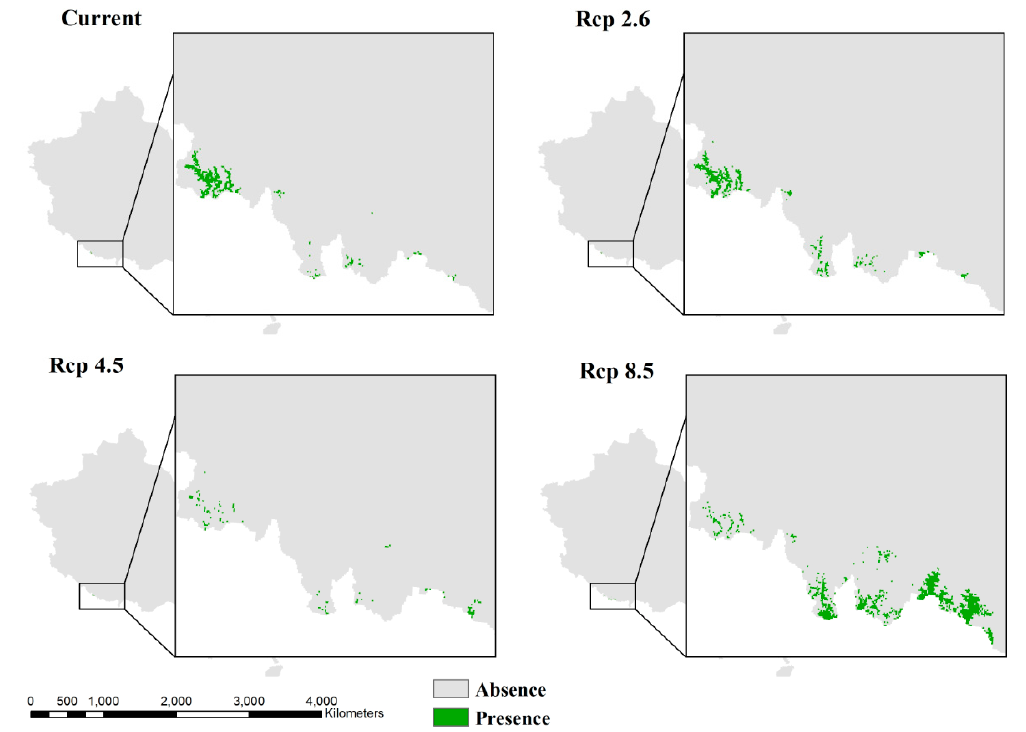
6 of 16 Figure 2. Binary distribution maps for T. cuspidata under current and future (RCP 2.6, RCP 4.5, and RCP 8.5 in 2070) environmental conditions, simulated by SDMs with the constraints of topography. In models without constrains of topography, all Taxus species would show different-level range changes, compared with the results of SDMs with the constraints of topography (Table 2). The range